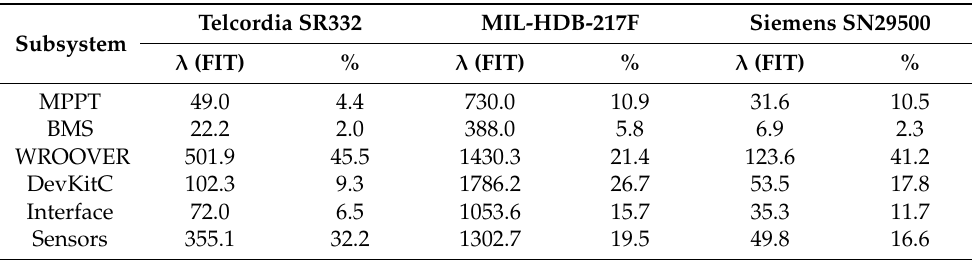
Table 1. Failure rates and their corresponding percentage values for Sensor nodes using Telcordia SR332, MIL-HDB-217F and Siemens SN29500.